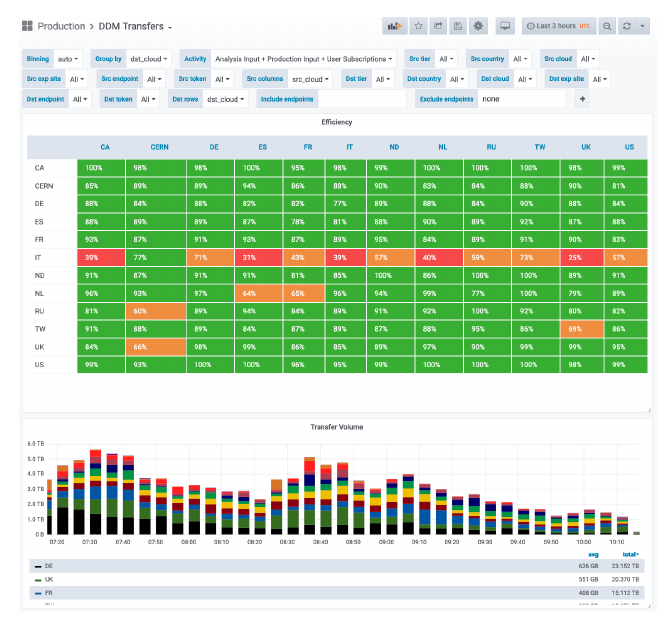
Figure 2. Overview of the DDM Transfer